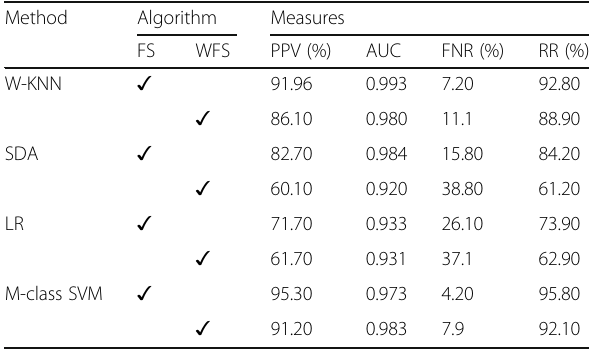
Table 9 Recognition results on Weizmann